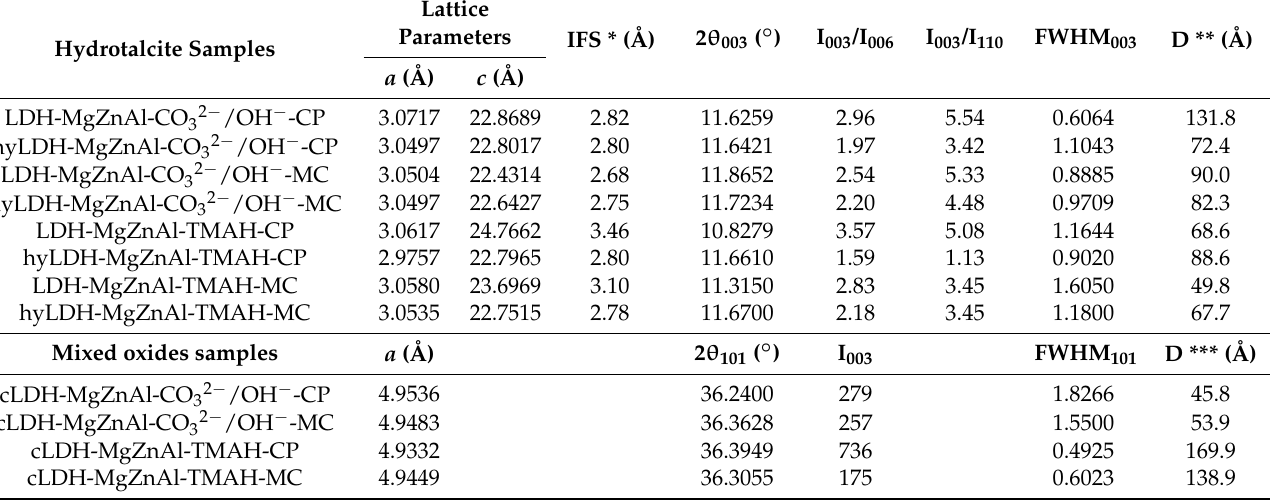
Table 1. The network parameter of